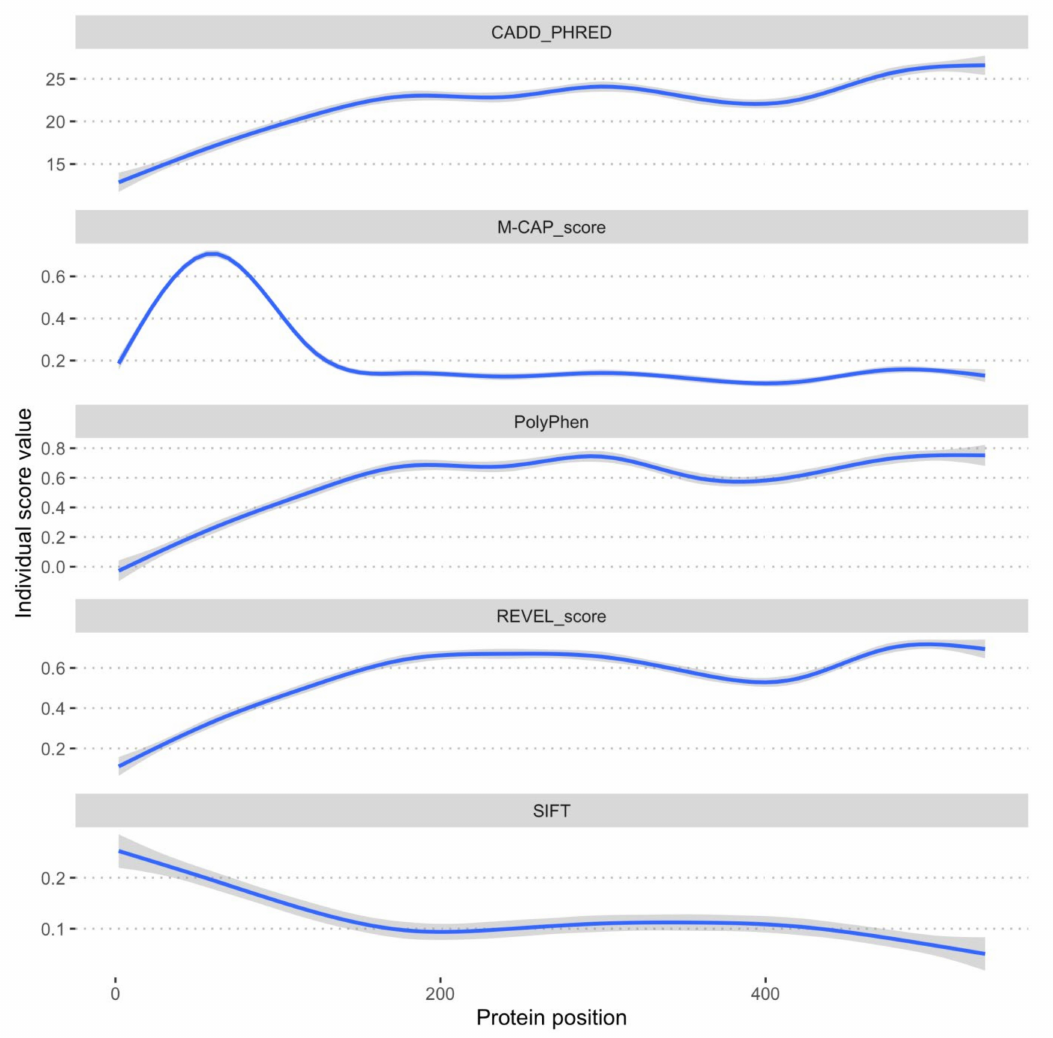
Figure A1. Computational polynomial regression model of 5 pathogenicity scores plotted against the linearized SSADH